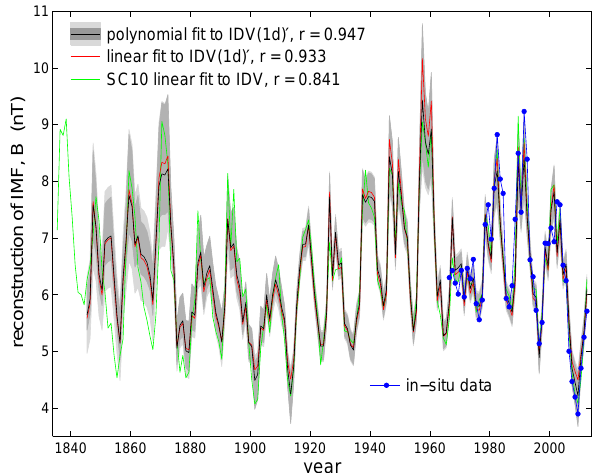
Fig. 7. Corrected version of Fig. 7 of Lockwood et al. (2013b) which gives reconstructions of the near-Earth IMF, B , from geomagnetic data. The black line uses the corrected geomagnetic activity com- posite, IDV(1d) and the polynomial fit to B derived in Lockwood et al. (2013b). The dark grey area surrounding this black line is the uncertainty band associated with using this polynomial fit derived using a Monte Carlo technique (see Lockwood et al., 2013b) and the light grey area convolves this uncertainty with the measurement uncertainty. The red line shows the best reconstruction using their linear fit. The green line shows the SC10 reconstruction. Blue dots show the annual means of the observed IMF.